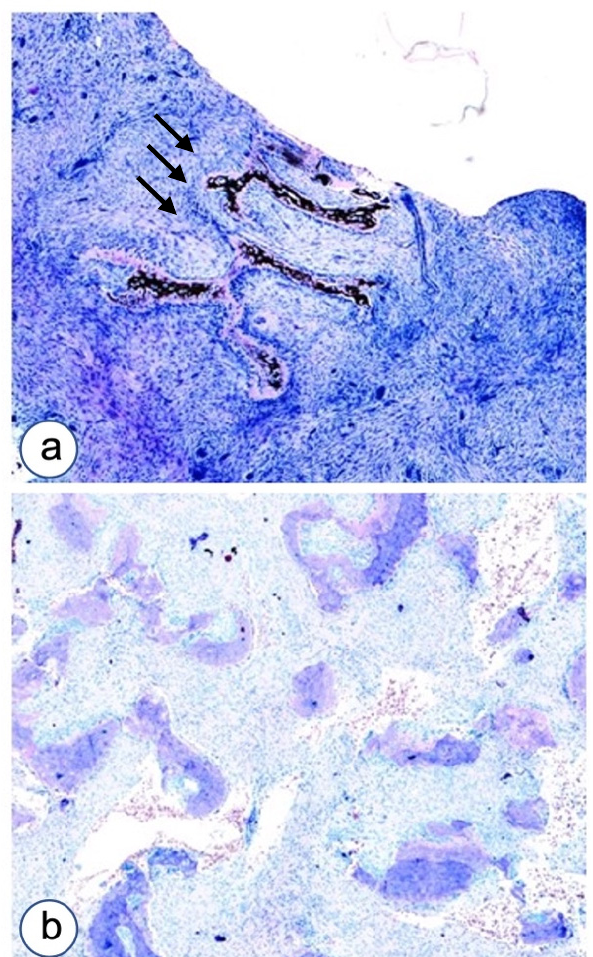
Figure 1. Microscopic aspects of impaired differentiation in Fibrous dysplasia of the jaw as evaluated by Von Kossa–Giemsa histochemical staining. ( a ) A case with Chinese ideogram aspect and high cellularity composed by fibroblastoid cells committed to osteoblast differentiation associated with giant cells. ( b ) Another case of FD with curved thin trabeculae of osteoid with high cellularity. Magnifications, ×4 (a,b).